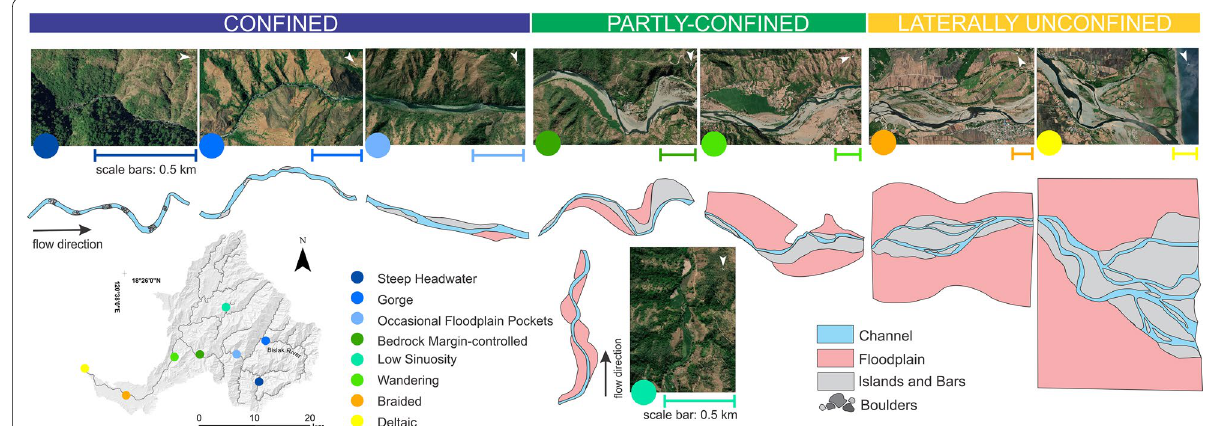
Fig. 3 River morphological diversity in the Bislak Catchment. Flow direction in the catchment is generally from east to west. Planform diagrams and aerial photos of the eight River Styles are arranged in a downstream sequence from left to